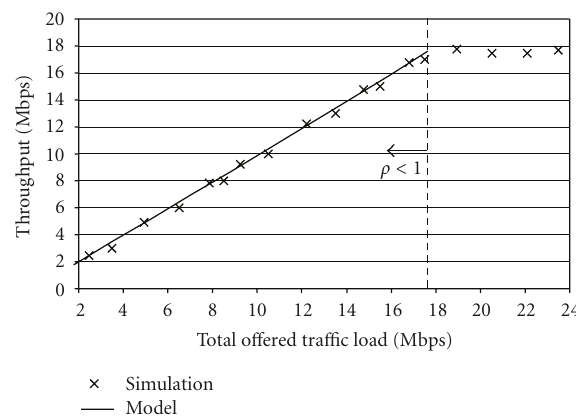
Figure 8: Non-Saturation Throughput (Model versus Simulation).